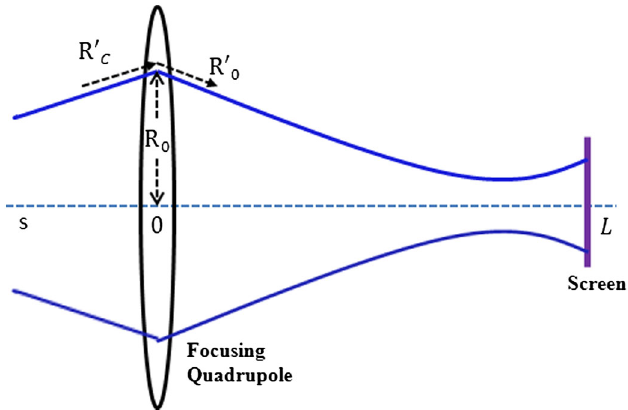
FIG. 1. Diagram of a quadrupole scan setup to measure emit- tance. Beam enters the quadrupole with envelope R 0 and slope R 0 and leaves it with slope R 0 0 C